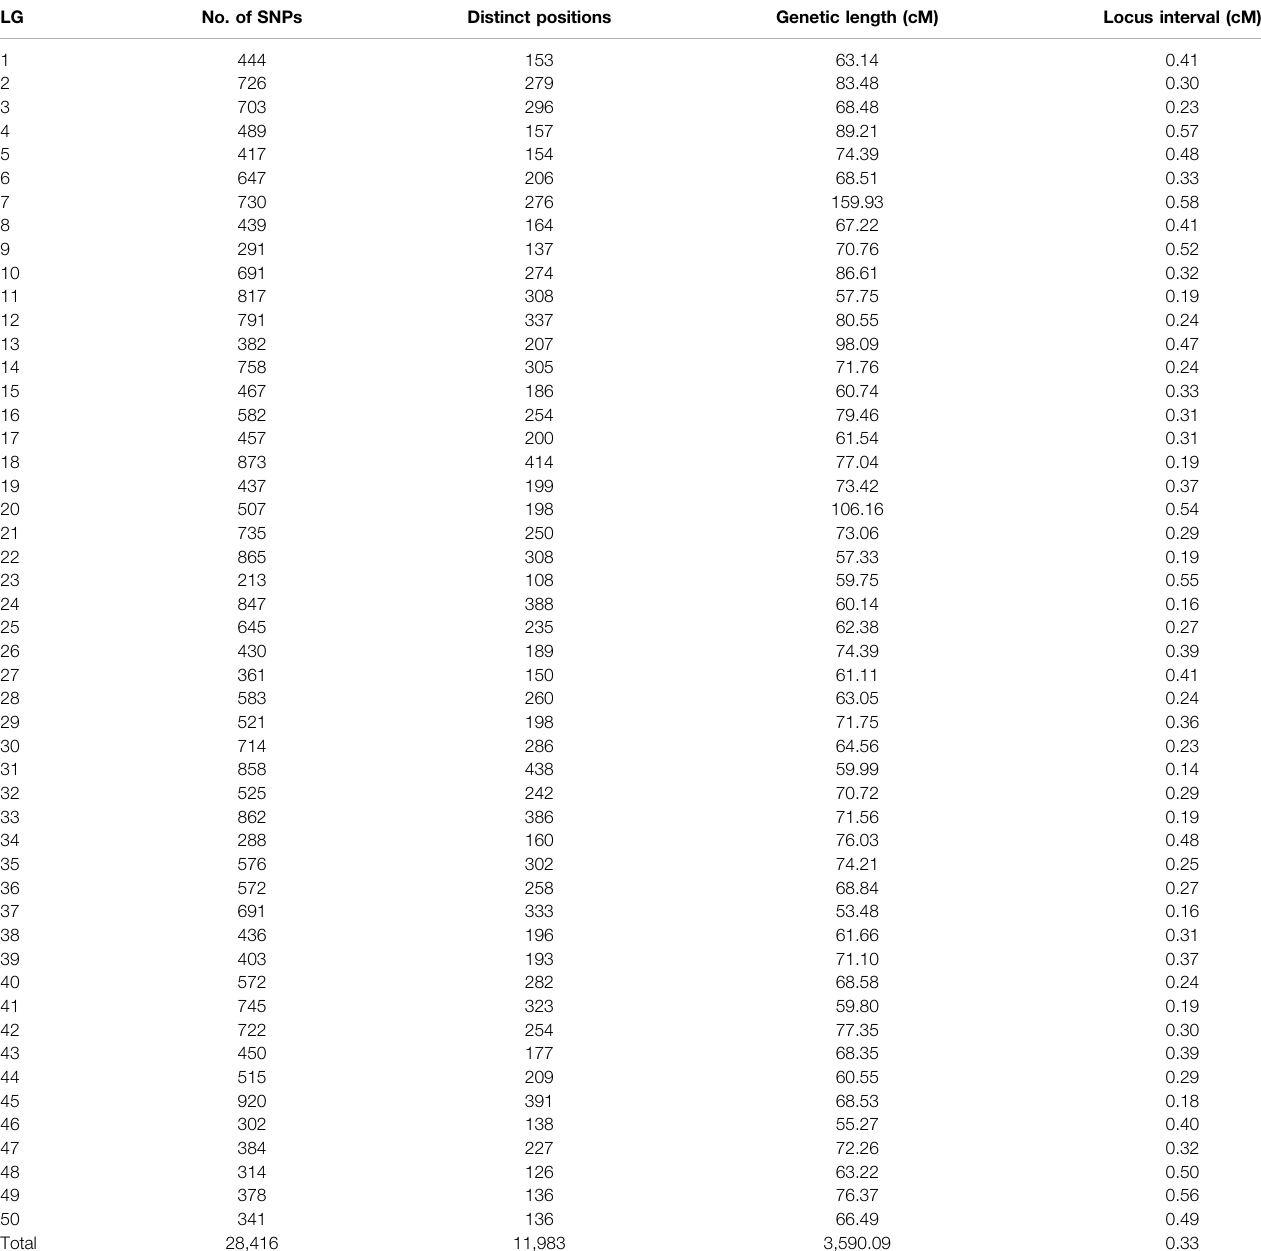
TABLE 3 | Summary of the linkage map of the mirror carp. LG No. of SNPs Distinct positions Genetic length (cM) Locus interval